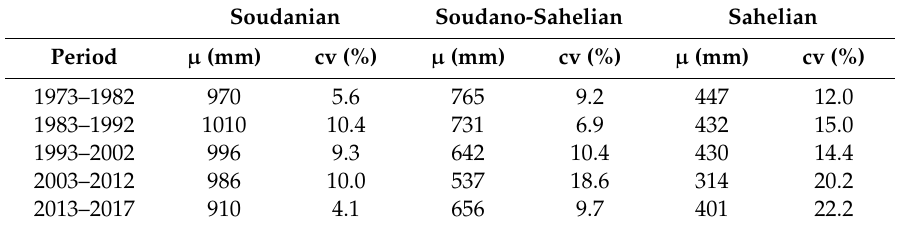
Table 4. Changes in annual precipitation ( µ ) and interannual rainfall variability (cv) along the di ff erent agroclimatic zones (Soudanian, Soudano-Sahelian, and Sahelian) for the period 1973–2017. Soudanian Soudano-Sahelian Sahelian Period